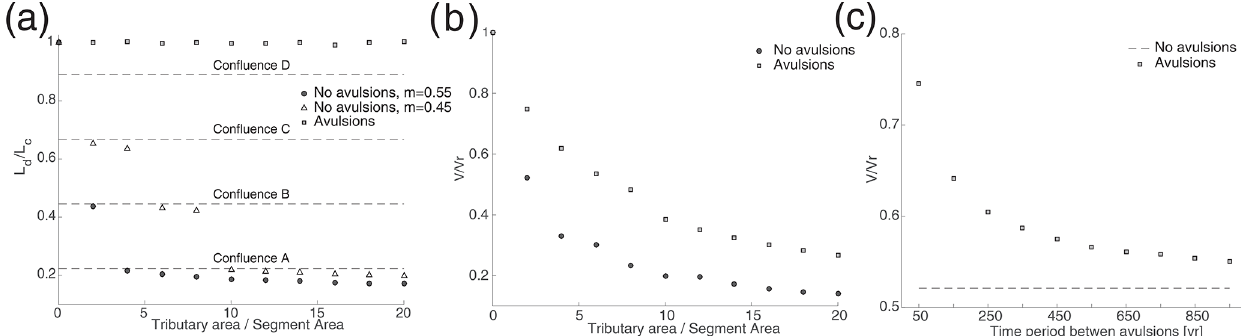
Figure 7. e influence of tributary area and avulsion frequency on wind-gap migration. Note that every marker in panels (a–c) represents the results of a single simulation. (a) The influence of tributary area and the area exponent m on the position of the stable wind gap relative to the center of the model domain (i.e., L d /L c , Fig. 5). When the stable position is closer to the center, the value L d /L c is closer to unity. Tributary drainage area ( A t ) is normalized by the area of the valley segment between tributaries. Note that stable wind-gap positions are typically next to a confluence on the shrinking valley side, whose location is marked by dashed horizontal lines. (b) The influence of tributary area (normalized as before) on the mean velocity of wind-gap migration. This velocity ( V ) is computed based on the location and time of where and when the wind gap reaches a stable position in the fixed confluence simulations and is normalized by the mean velocity ( V r ) of the reference simulation with the same total drainage area. (c) The influence of time interval between avulsions on the mean velocity of wind- gap migration (computed with the same procedure described before) for the case in which the area of tributaries is twice the segment area. The dashed line marks the velocity of an equivalent fixed confluence simulation. Model parameters are given in Table